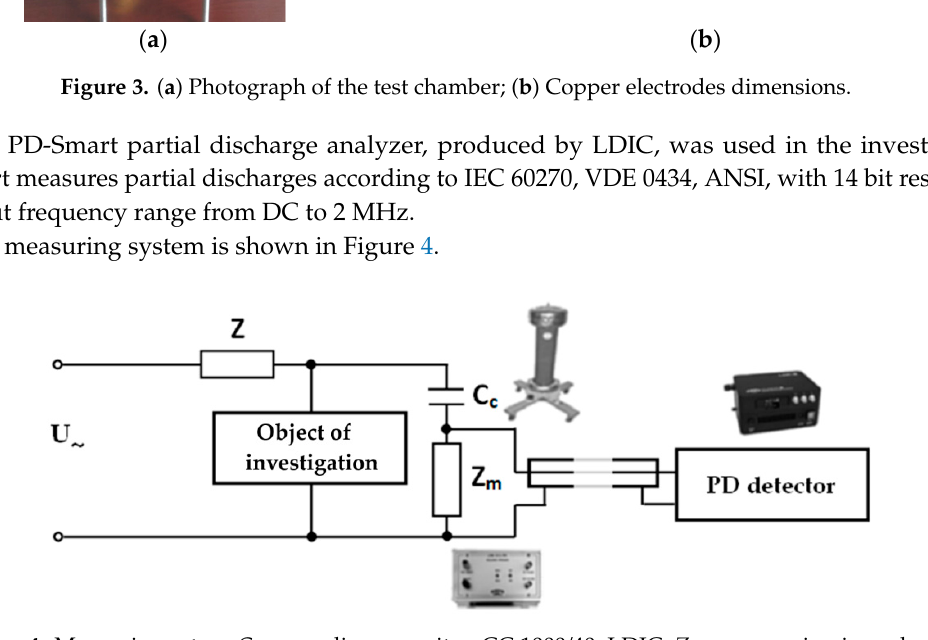
Figure 4. Measuring setup; C c — coupling capacitor, CC 1000/40, LDIC; Z m — measuring impedance, LDM — 5/U, LDIC; PD detector — PD Smart, LDIC.